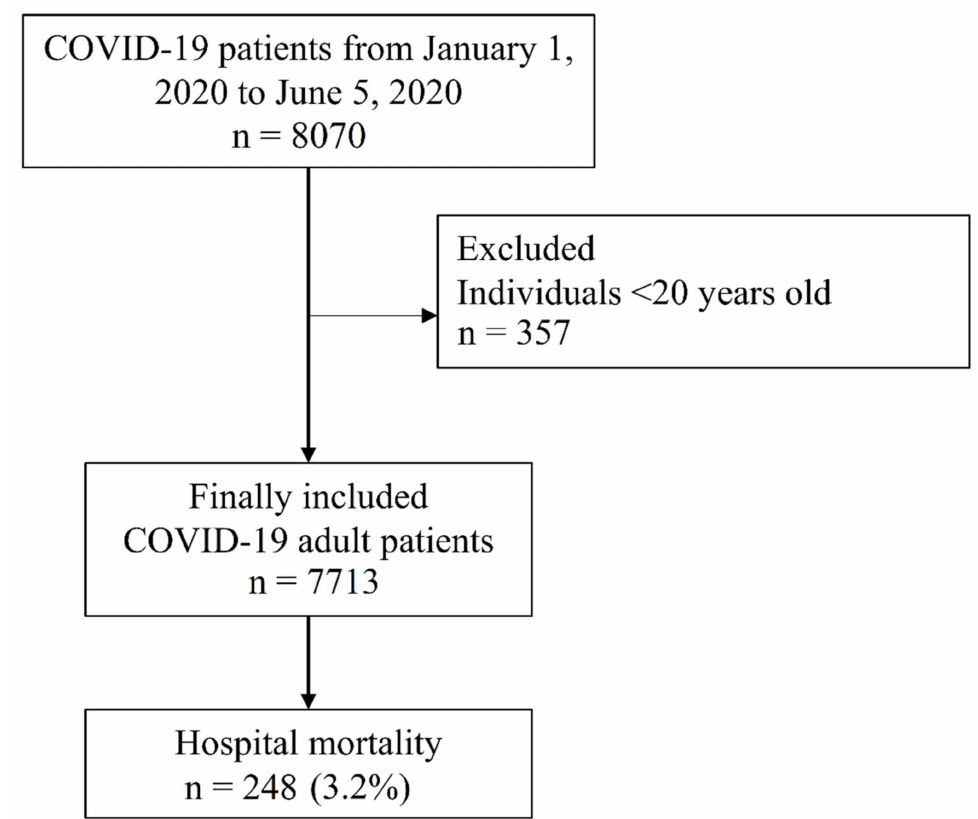
Figure 1. Flow chart depicting selection of patients with COVID-19 in South Korea. COVID-19, coronavirus disease